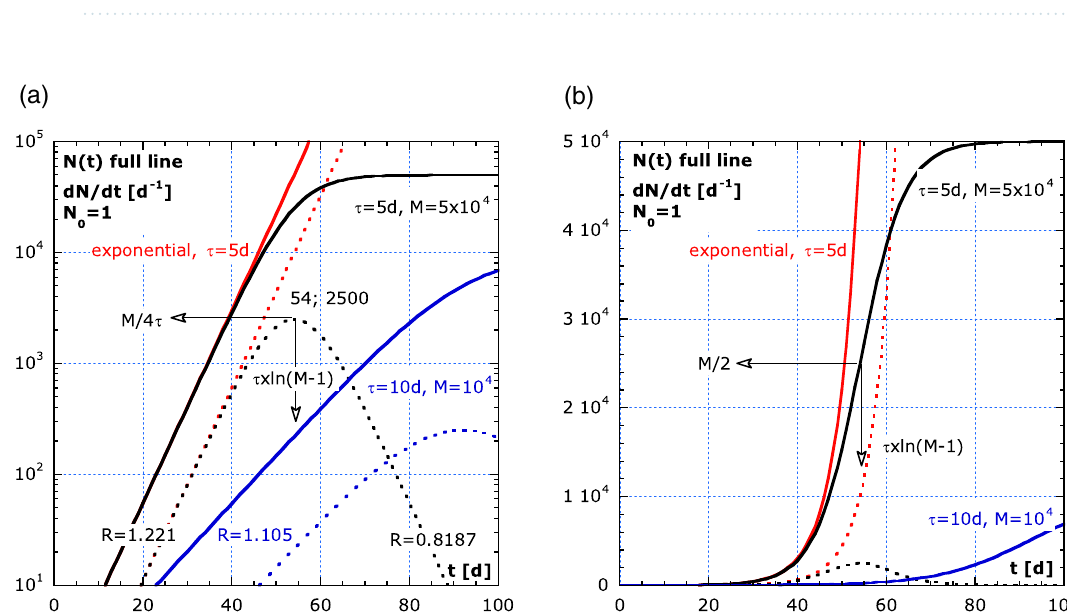
Figure 1. The exponential and limited growth in log–lin and lin–lin representation. ( a ) log–lin plot of the cumulative incidence, N(t) and the pandemic curve, the new infected persons per day: ˙ N � t < τ . The values: R, t inf and N max depend on τ and M . ( b ) lin–lin plot of ( a ). The black line in ( b ) is the ˙ so-called S-curve, not visible in the log–lin plot. The small values are not visible to the human eye, if presented with large ones in a lin–lin